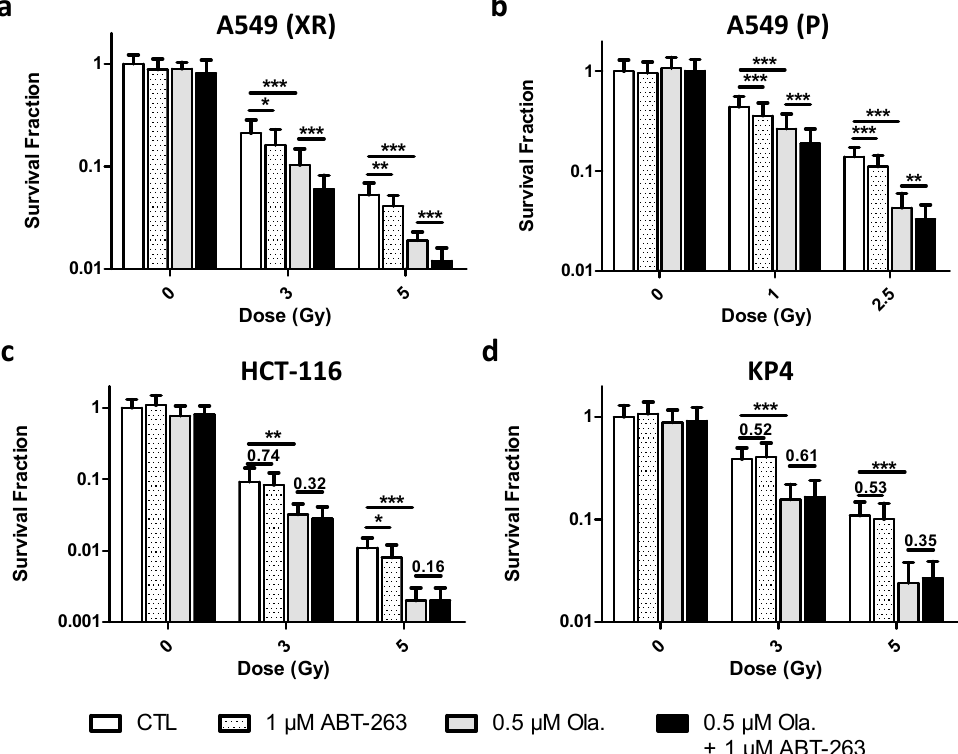
Figure 4. Non-toxic combination of ABT-263 and Olaparib can synergize after X-ray and proton irradiation to increase clonogenic cell death. A549, HCT-116 and KP4 cells were irradiated with 3 and 5 Gy X-rays or 1 and 2.5 Gy protons with or without 0.5 µM of Olaparib. The medium was replaced 22 h after irradiation, and 1 µM of ABT-263 was added. Colonies were stained and counted 8 days (KP4 cells) or 12 days (A549, HCT-116 cells) post-irradiation. ( a ) A549 cells after X-rays. ( b ) A549 cells after protons. ( c ) HCT-116 cells after X-rays. ( d ) KP4 cells after X-rays. At least three independent experiments were performed, and data are presented as mean ± 1 SD. Unpaired t -tests were performed (*: p < 0.05; **: p < 0.01; ***: p < 0.001) for CTL vs. ABT, CTL vs. Ola and Ola vs. Ola + ABT.